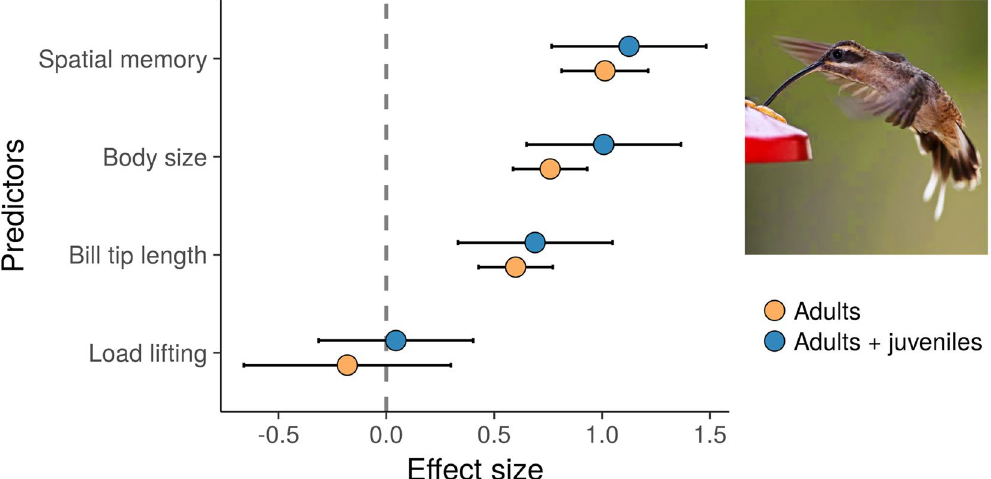
Figure 1. Standardized effect sizes and 95 confidence intervals of functional, morphological and cognitive traits for predicting territory acquisition in lekking long-billed hermit males. Effect sizes are shown for models on the complete data set, including juveniles (n = 30, blue markers) and the one on the subset of adult males (n = 20, orange markers). Effect sizes with confidence intervals that do not overlap with zero (highlighted by the vertical dashed line) were considered to have an effect on lek territory ownership. Photo (by David McDonald) shows a long-billed hermit visiting a feeder like those used in the spatial memory test.